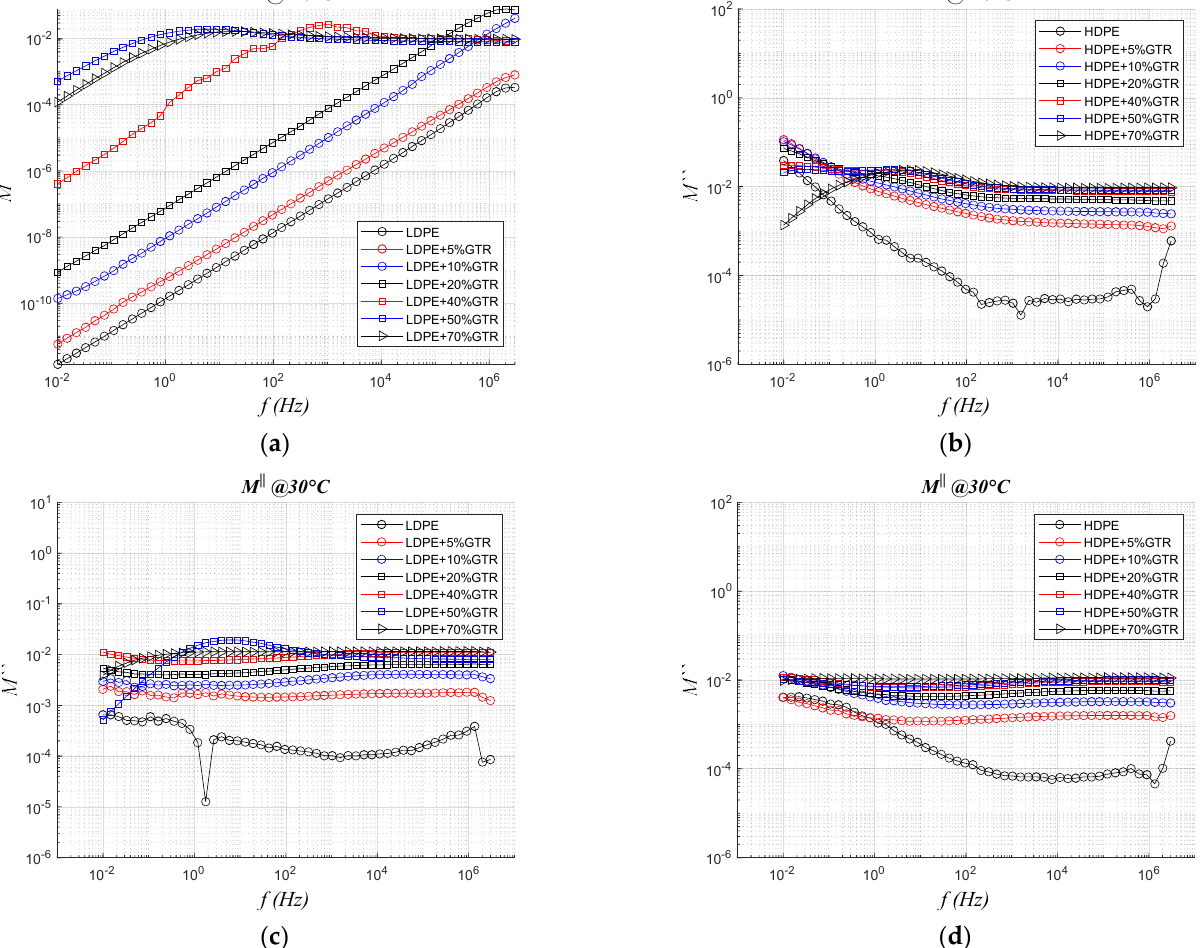
Figure 9. Electrical Imaginary Modulus (M”) on frequency dependence for ( a ) LDPE/GTR at 120 °C; ( b ) HDPE/GTR at 120 °C; ( c ) LDPE/GTR at 30 °C; and ( d ) HDPE/GTR at 30 °C.